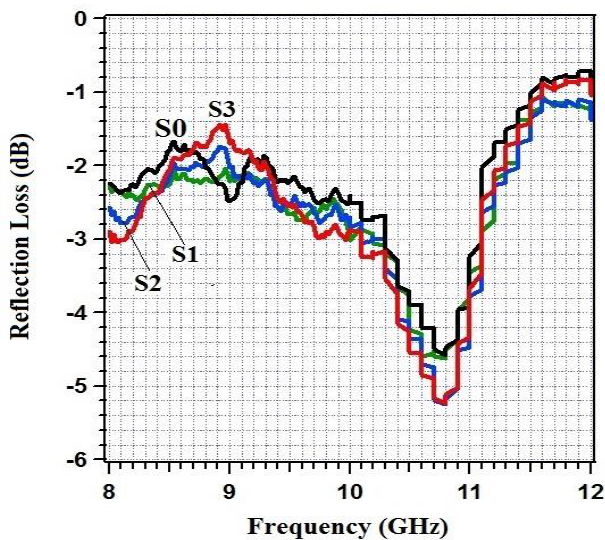
The interaction of the ceramics with electromagnetic waves characterized by using an HP8720B vector